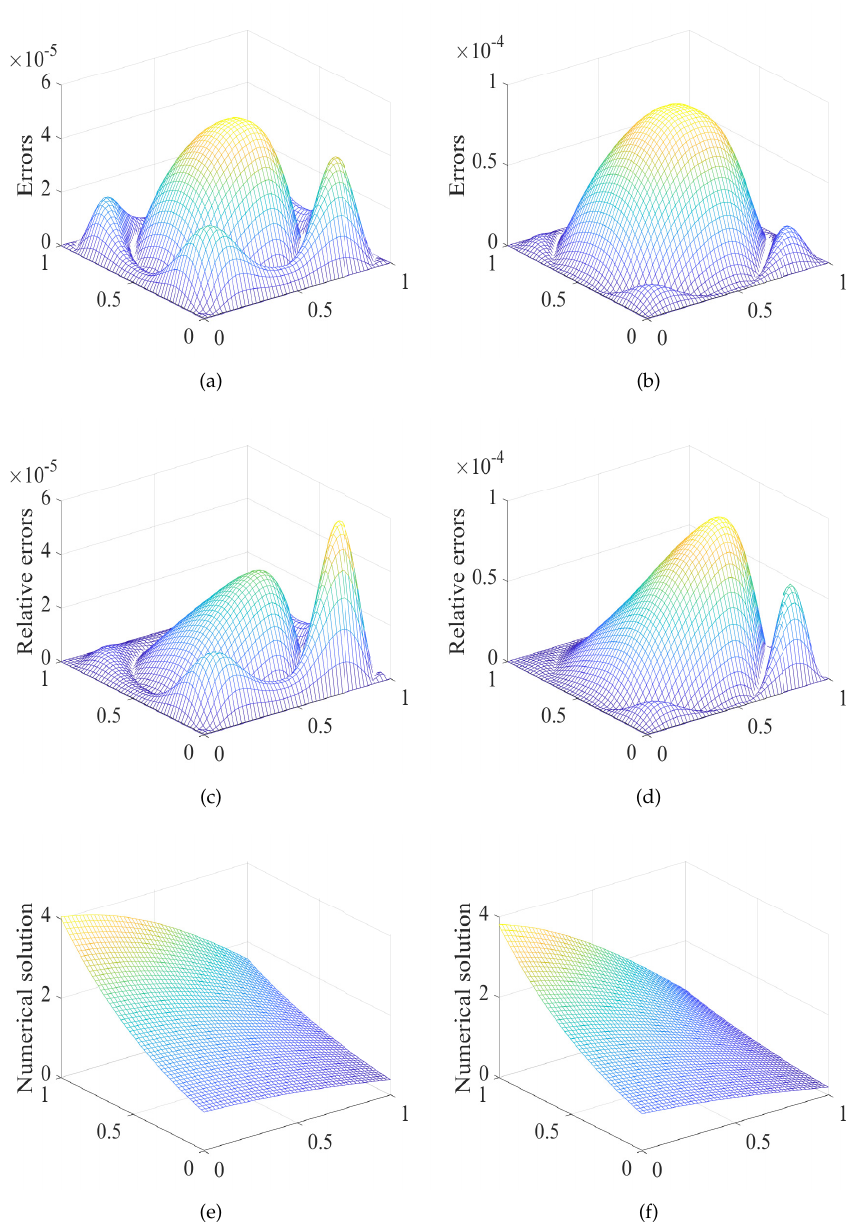
Figure 5. The errors, relative errors and numerical solutions of the AAI algorithm at z = 1/3,2/3 when l = m = s = 51, h = 1/50, n = 150, ω = 1.94. ( a ) The errors at z = 1/3; ( b ) The errors at z = 2/3; ( c ) The relative errors at z = 1/3; ( d ) The relative errors at z = 2/3; ( e ) The numerical solution at z = 1/3; ( f ) The numerical solution at z =